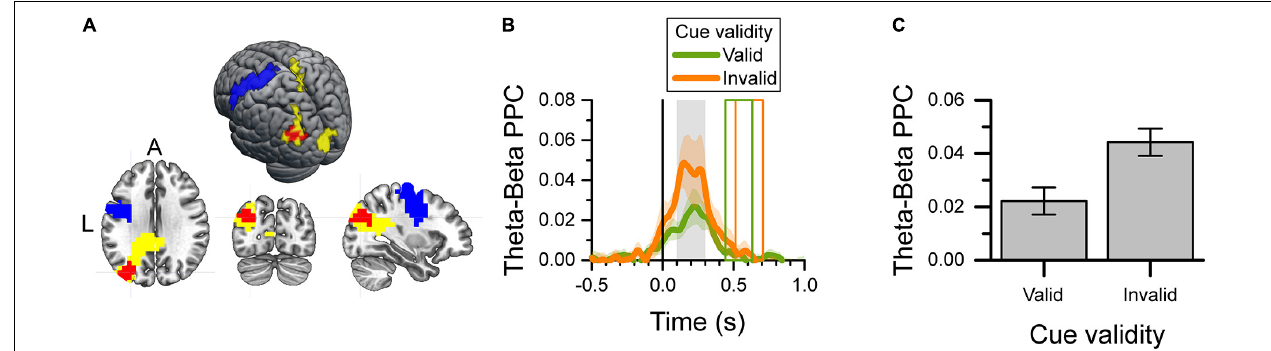
FIGURE 5 | Theta-beta cross-frequency analysis of valid-cue and invalid-cue trials during the 0.1–0.3 s after target onset. (A) Map and surface projection on the MNI brain of voxels included in the analysis. The yellow voxels identify those with a significant effect of cue validity (see Figure 4 ), and used as the source of the theta-band signal. The blue voxels identify the left precentral gyrus (M1) area used as the source of the beta-band signal. The significant cluster of voxels with a difference in PPC between valid and invalid cue trials selected by the cluster-based analysis are shown in red. (B) Target-aligned time-series of theta-beta phase-amplitude PPC per cue validity condition for the red voxels in (A) . The color shaded area indicates the SEM ( N = 12) for within-subject design. The gray area identifies the period of interest in the PPC analysis. The colored rectangles show the average onset and offset of the motor response for the valid-cue and invalid-cue conditions. (C) Average theta-beta phase-amplitude PPC during the 0.1–0.3 s after target onset (gray rectangle in B ) for the selected voxels (red in A ) per cue-validity condition. Error bars indicate the SEM ( N = 12) for within-subject